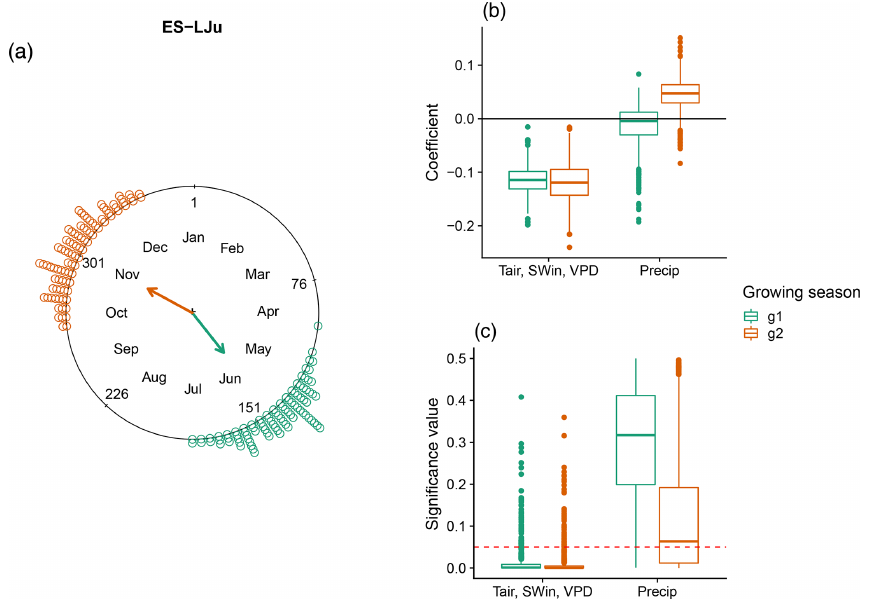
Figure 6. DOY GPPmax sensitivity to different climate drivers in a Mediterranean ecosystem: Llano de los Juanes (ES-LJu), Spain, with two growing seasons (green and orange). (a) DOY GPPmax distribution across the year. The arrows indicate the mean angular direction of the growing season. (b) Regression coefficients for each growing season and (c) the significance values for each variable. The red line in panel (c) represents a p value of